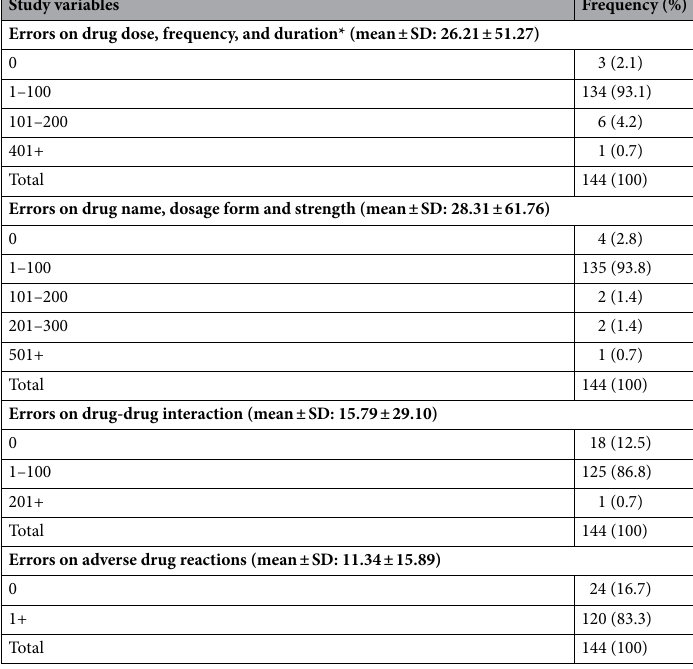
Table 6. PC practices concerning DTRP identification. *Errors on drug dose refer to mistakes in writing dose of medicine or did not write it (either omission and commission type). *Errors on frequency refers to mistakes in writing frequency/regimen of medicine or did not write it (either omission and commission type). *Errors on duration refer to mistakes in drug duration writing or did not write it (either omission and commission